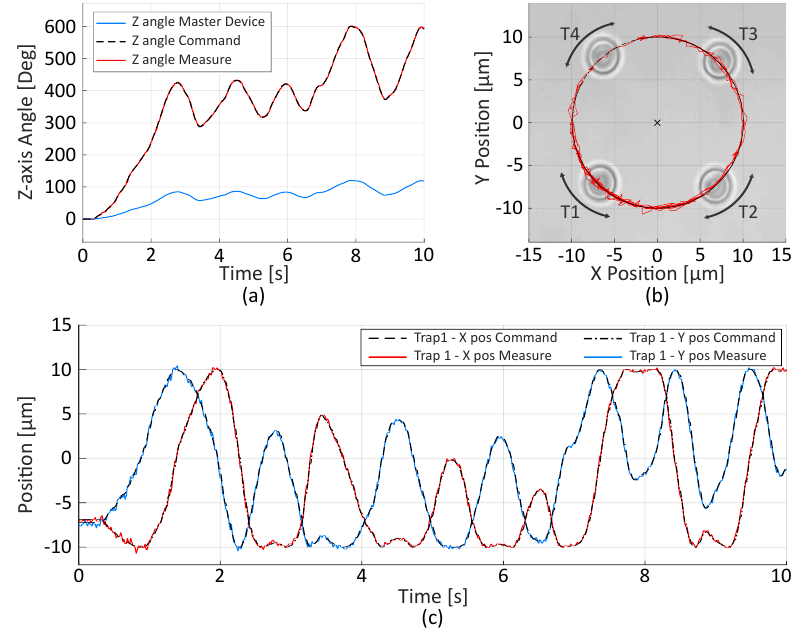
Figure 4. Example of teleoperated rotation in position mode of a group of four micro-beads. ( a ) The master device orientation and the command sent to the actuators. Z angle is the angle of rotation around the z-axis. The scaling factor is set to 5 in order to allow a complete rotation. The measured angle is estimated from the measured position of Trap T1. ( b ) The 2D trajectory followed by the Trap T1. ( c ) The measured position of Trap T1 computed from the video and the set-point. Estimated error is 0.31 µm with a standard deviation of 0.23 µm.